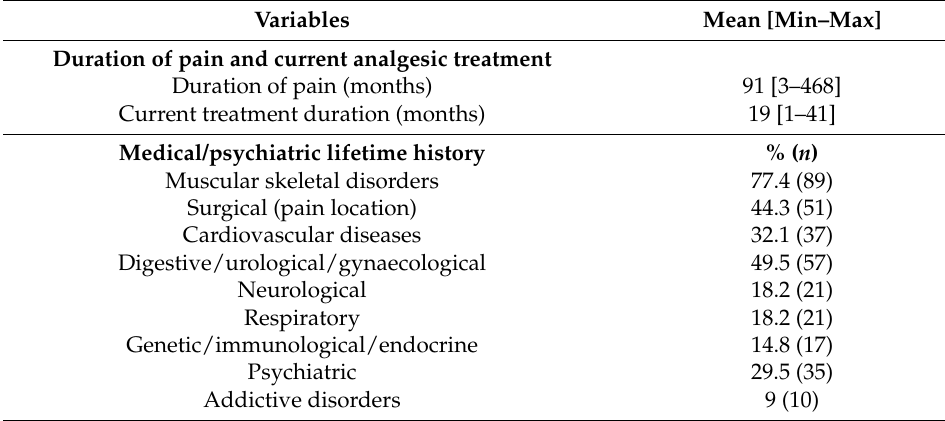
Table 1. Characteristics of the population.